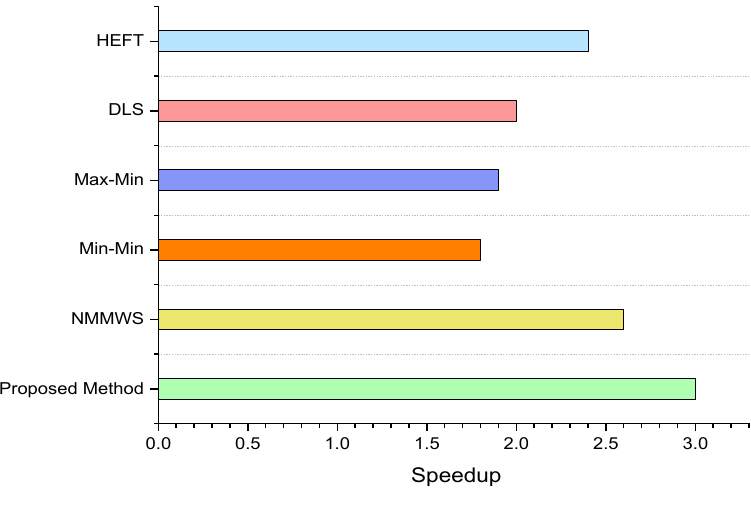
Figure 12. Speedup.